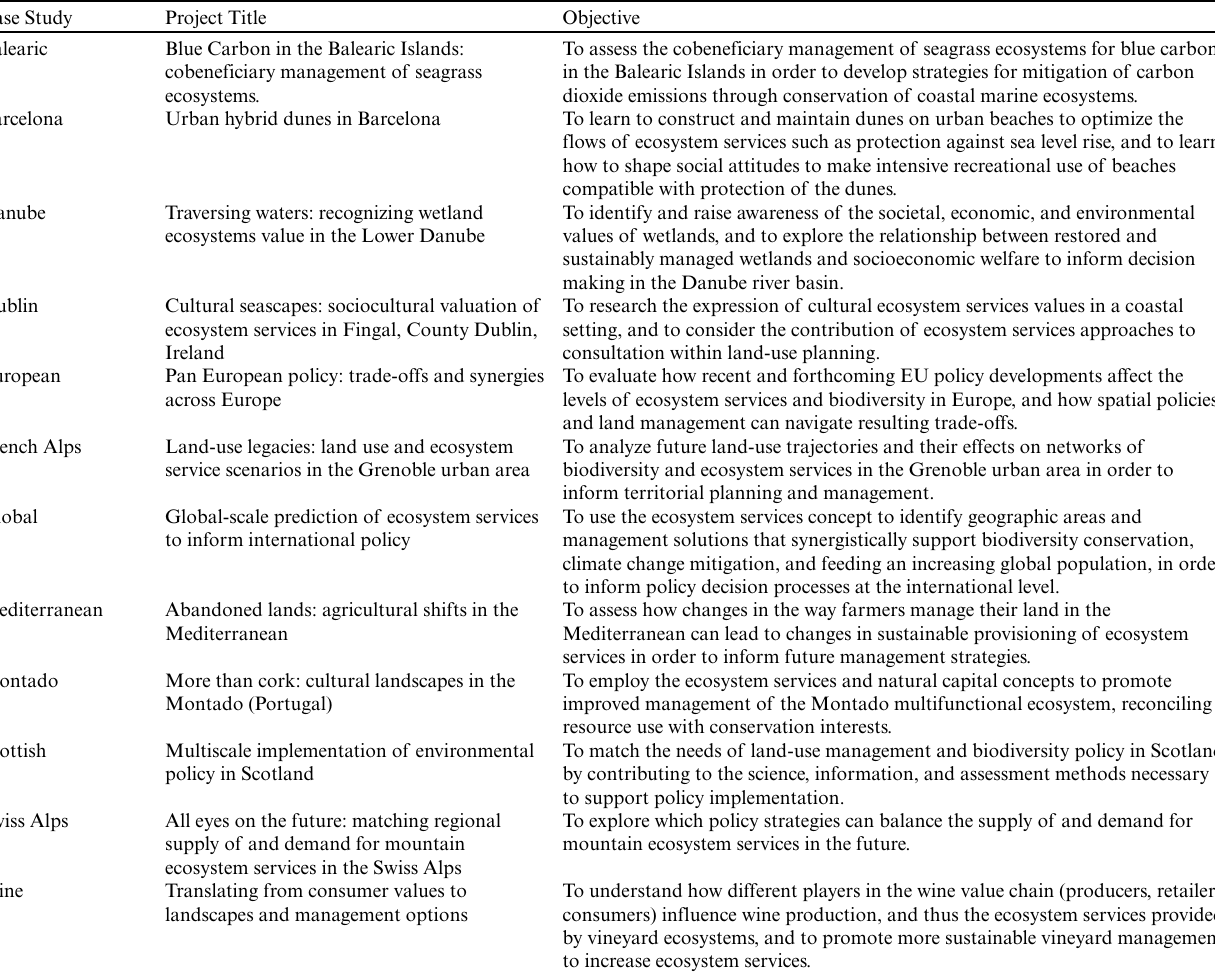
Table 1. Brief descriptions of the 12 case studies in the OPERAs European ecosystem services research project. More complete information is available on